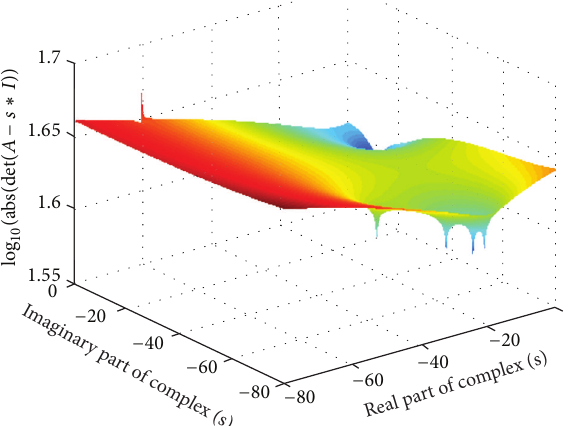
Figure 5: Three-dimensional diagram of log(abs (𝑊(𝑠) )).